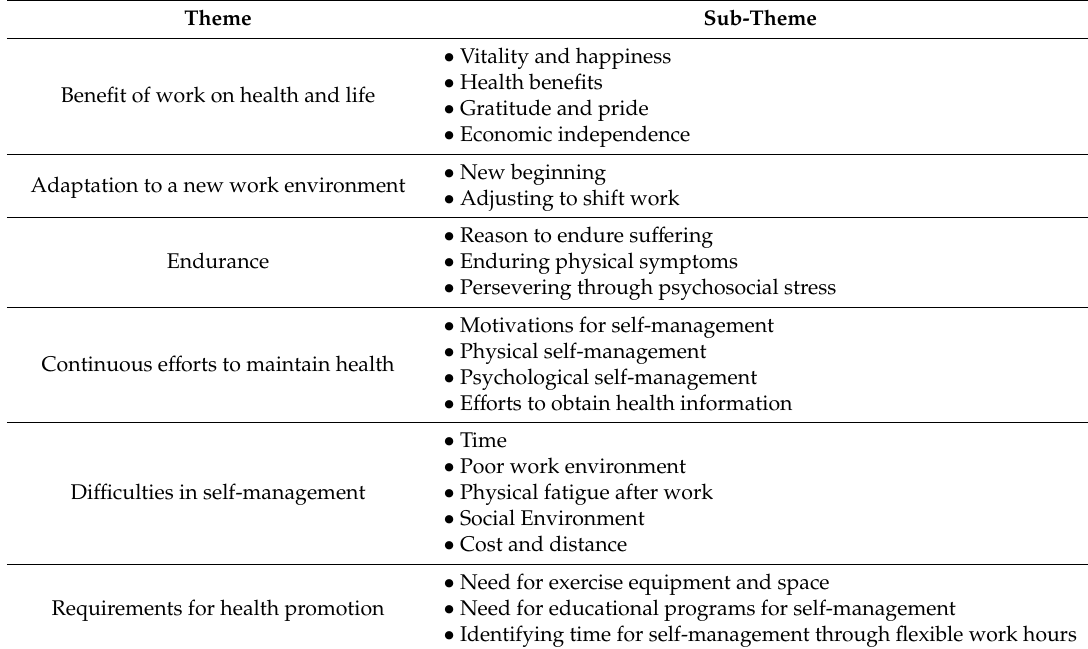
Table 2. Outcome of qualitative